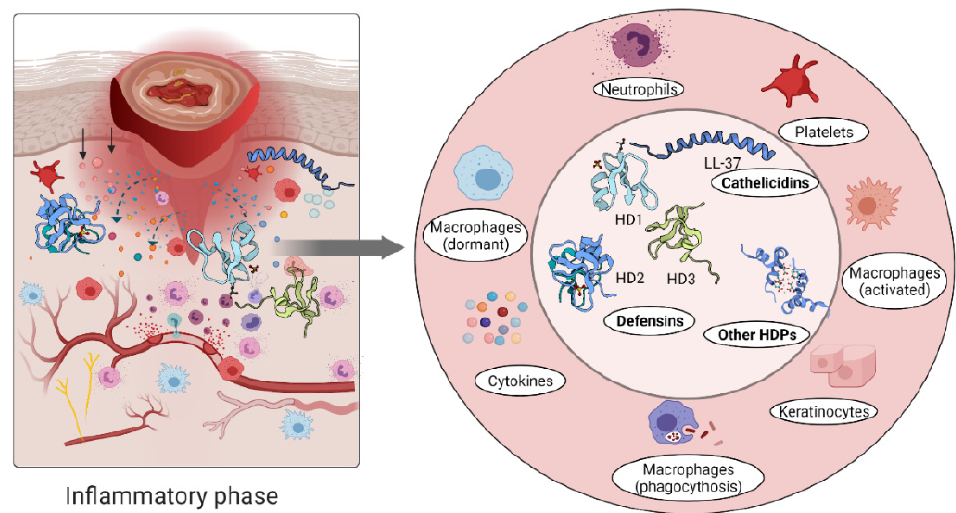
Figure 3. Immune response triggers skin cells to secrete host defence peptides. The secreted peptides are involved in antibacterial killing but also the recruitment of other immune cells to the wounded area.